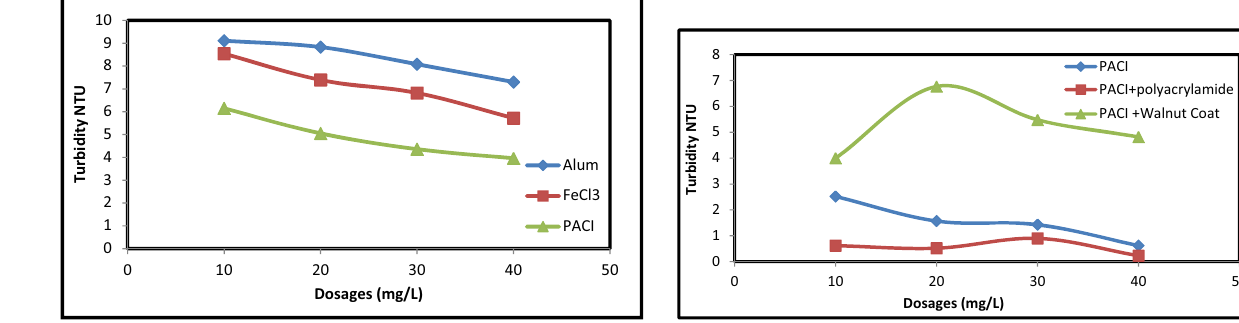
Figure 18: The relation between the coagulant aids and fi nal tur - bidity for water samples at a height of 60